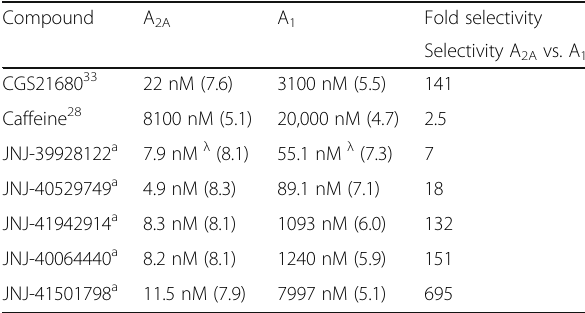
Table 1 Affinity constants indicated as IC 50 in nM (and the corresponding pIC 50 ) for the compounds used in the present